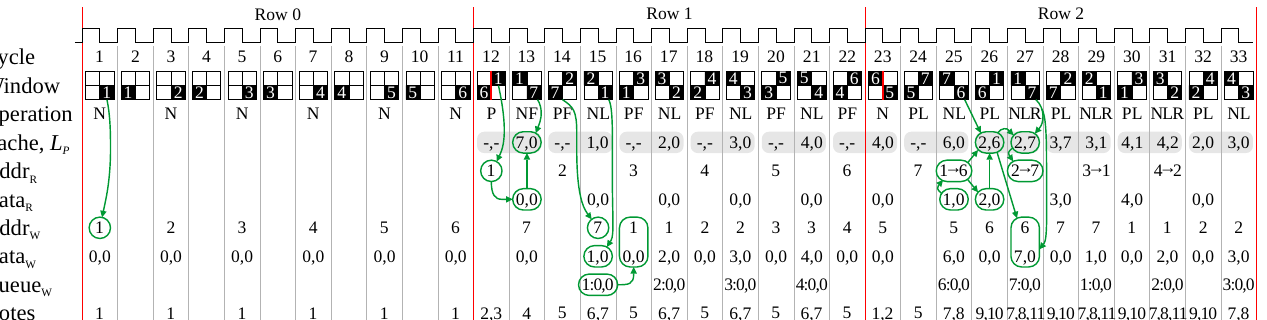
Figure 5. Memory accesses when processing the worst-case image of Figure 4. The red lines corre- spond to the EOL boundary. The run/node indices are shown for each 2 × 2 window. The -,- for the cache indicates that the cache content is invalid. In the read address for a link, the number after the → indicates the index to be added. Notes: 1 . The N-operation initialises LT [ C ] for the new node. 2 . There is no link from this pattern, because this is at the EOL and the start of the next. 3 . The P-operation reads LT [ P ] into the cache, L P . 4 . The F-operation directly updates the cache, and no chain is required for the first link (rule 2). 5 . The P-operation takes priority over the L- or F-operation. As the cache has not been loaded, processing the link is deferred to the following cycle (rule 3), where. 6 . the cache is updated directly and the chained link can be written directly, without first reading